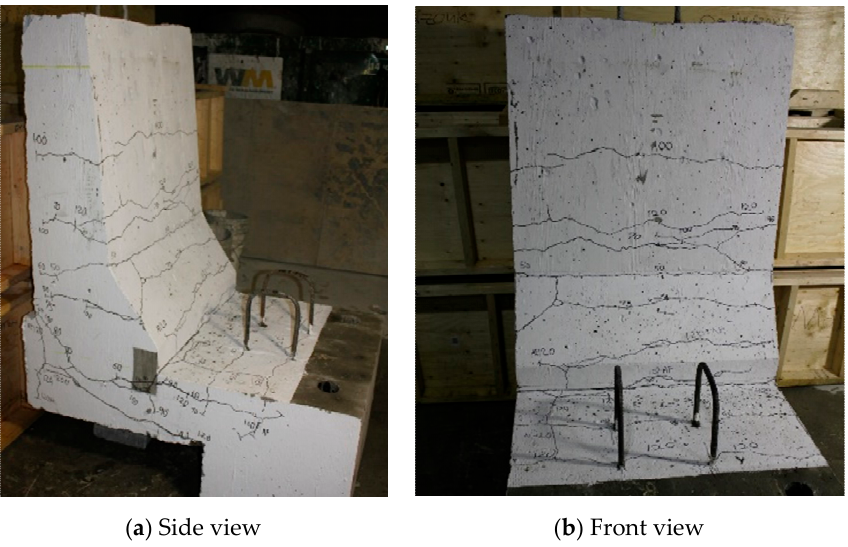
Materials 2019 , 12 , x FOR PEER REVIEW Figure 14. Specimen # 2 crack pattern. ( a ) Side view; ( b ) front view. Figure 14. Specimen # 2 crack pattern. ( a ) Side view; ( b ) front view.